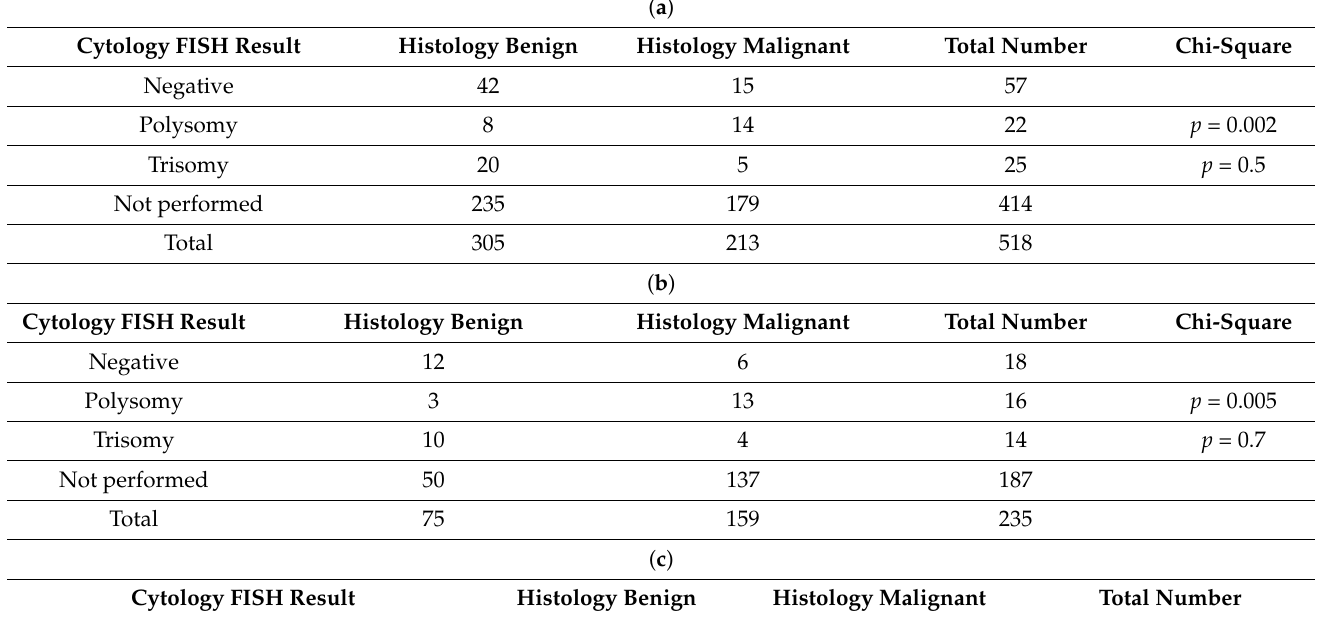
Table 6. ( a ) Correlation of cytology-negative cases with FISH and histological diagnosis. ( b ) Correla- tion of cytological atypia cases with FISH and histological diagnosis. ( c ) Correlation of suspicious cytology cases with FISH and histological diagnosis. ( d ) Correlation of cytological malignant cases with FISH and histological diagnosis. ( e ) Correlation of cytology non-diagnostic cases with FISH and histological